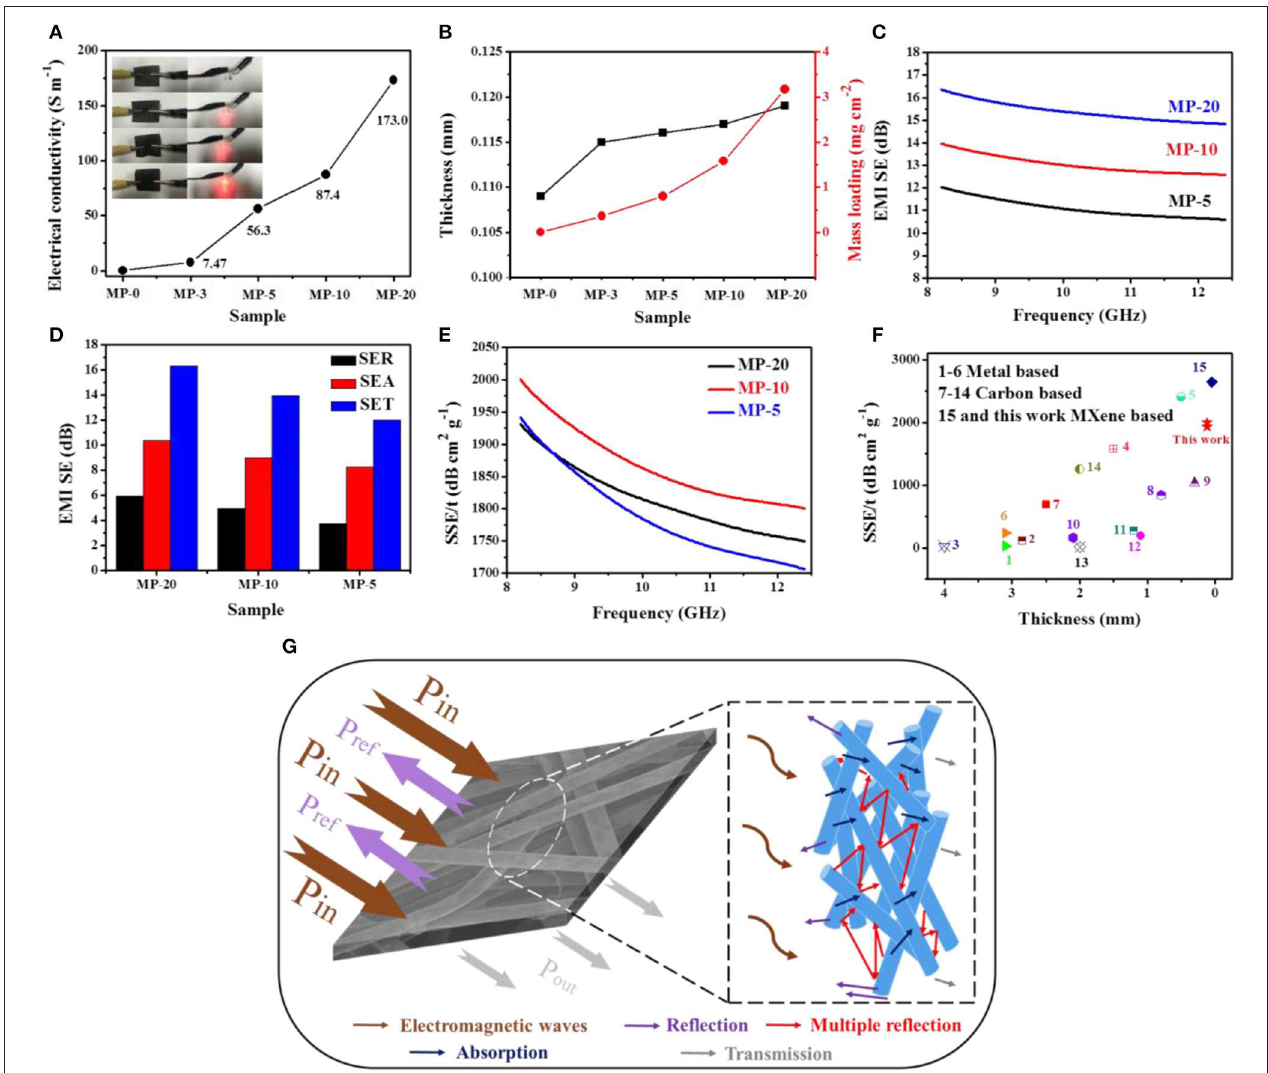
FIGURE 4 | (A) Plot of electrical conductivity vs. dipping times for composite papers in different dipping times; (B) plots of thickness and mass loading vs. dipping times for composite papers in different dipping times; (C) effect of dipping times on the EMI SE of the composite papers in different dipping times in the X-band region (8.2–12.4 GHz); (D) comparison of total EMI shielding effectiveness (SE Total ), microwave absorption (SE A ), and microwave reflection (SE R ) at a frequency of 12.4 GHz of the composite papers in different dipping times; (E) effect of dipping times on the SSE/t of the composite paper sheets in different dipping times in the X-band region (8.2–12.4 GHz); (F) comparison of the SSE/t as a function of the sample thickness, and the numbers in (F) are sample numbers listed in Table S1 ; (G) schematic illustration of the electromagnetic wave transfer across the composite